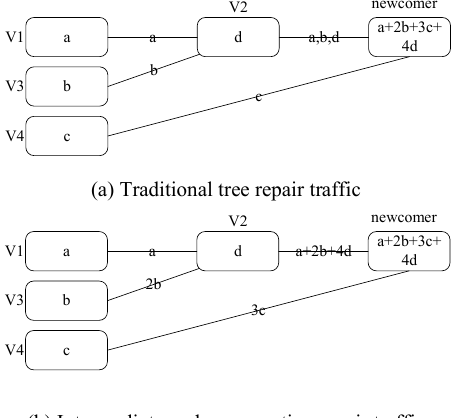
Figure 2. Link aggregation and intermediate tree repair mechanism.